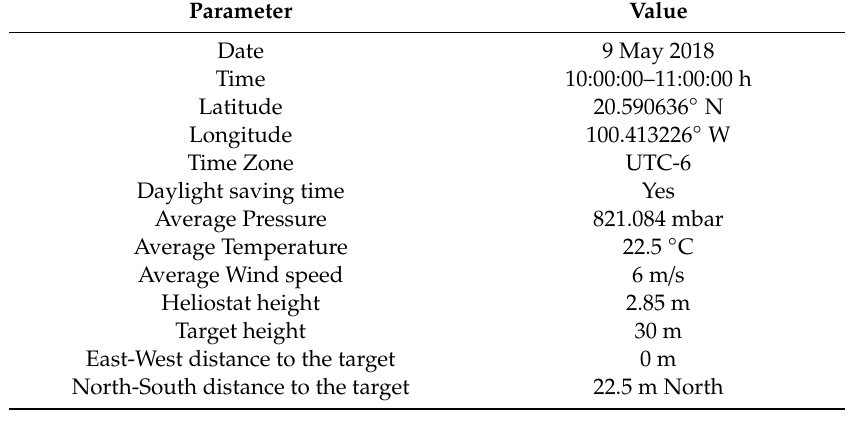
Table 5. Parameters of the orientation control test.